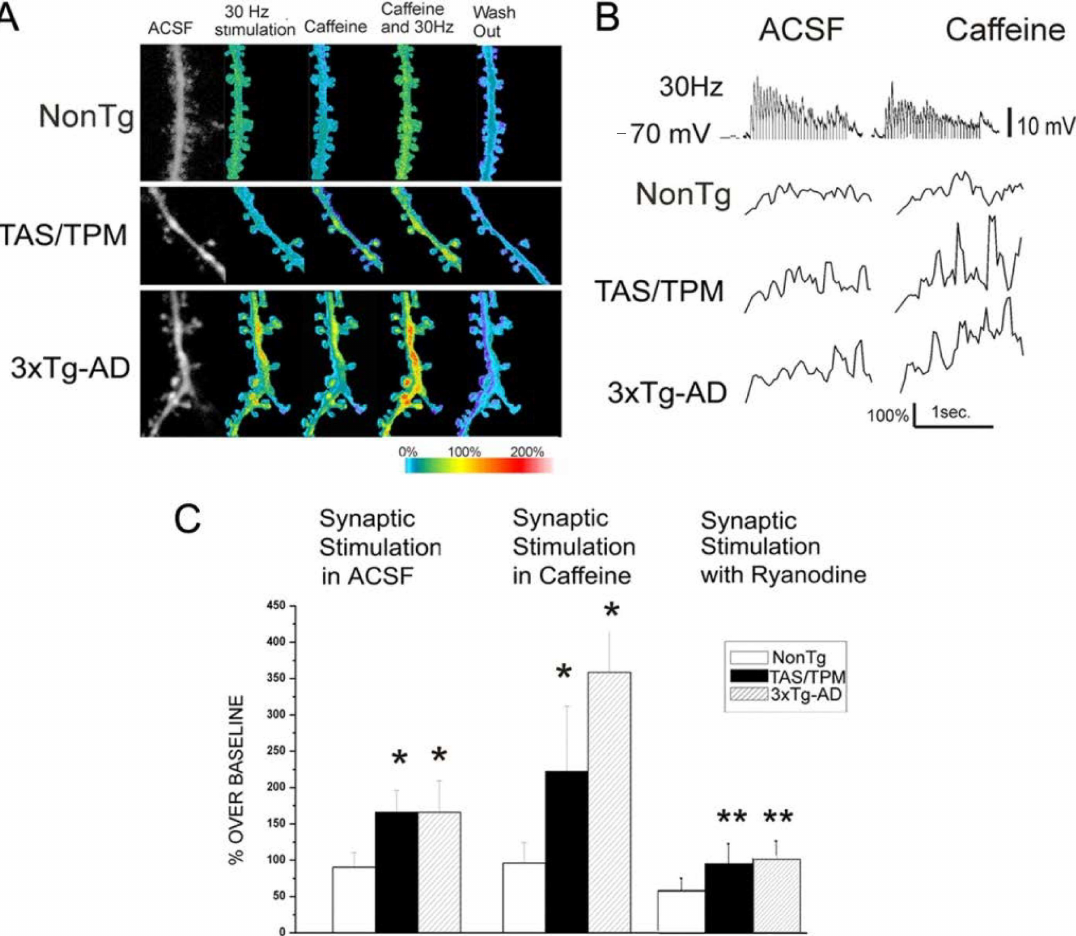
Figure 1. Synergistic Ca 2 + interactions between RyR and glutamatergic synaptic transmission in